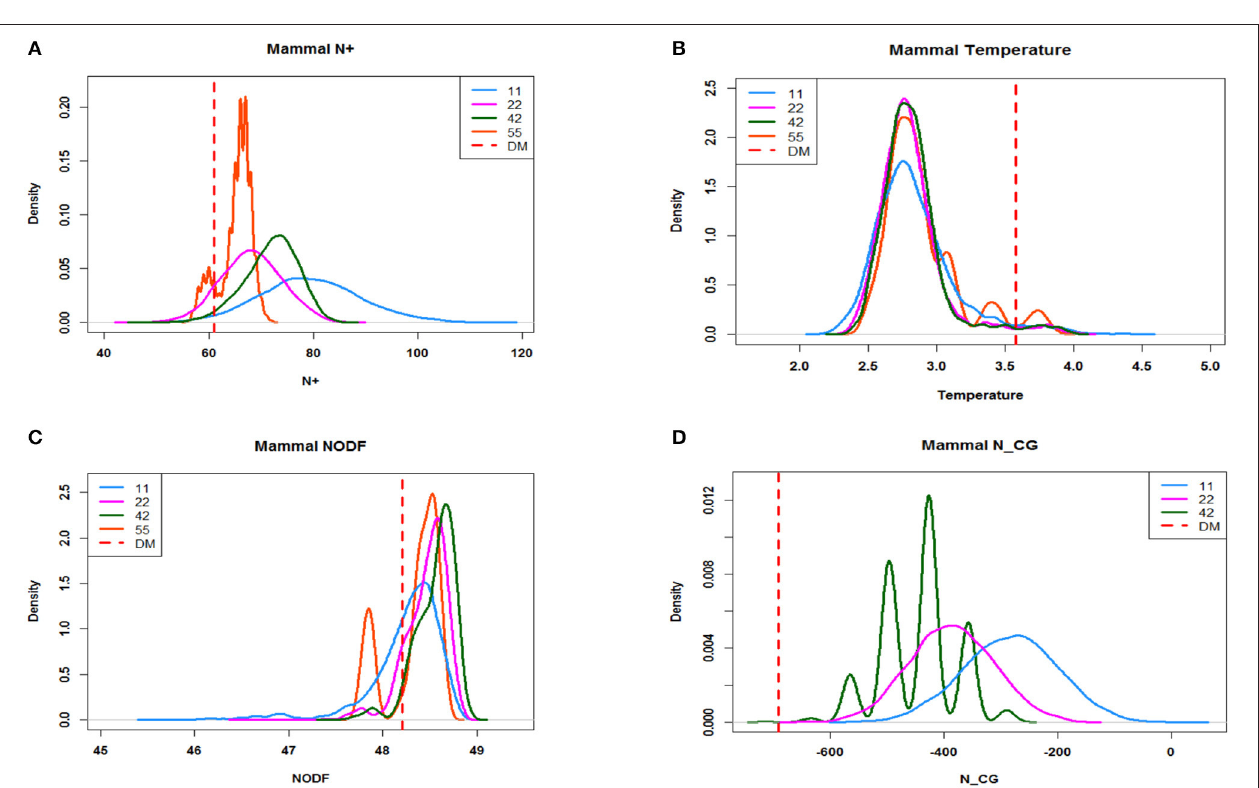
FIGURE 4 | (A) Two energy trajectories from two scales of matrix structures. The light blue ones are sampled with fixed row and column sums of the overall matrix; however, the orange-red ones are sampled with fixed row and column sums in each 5 × 5 block. (B) Four energy distribution curves fit four different scales of block structures.